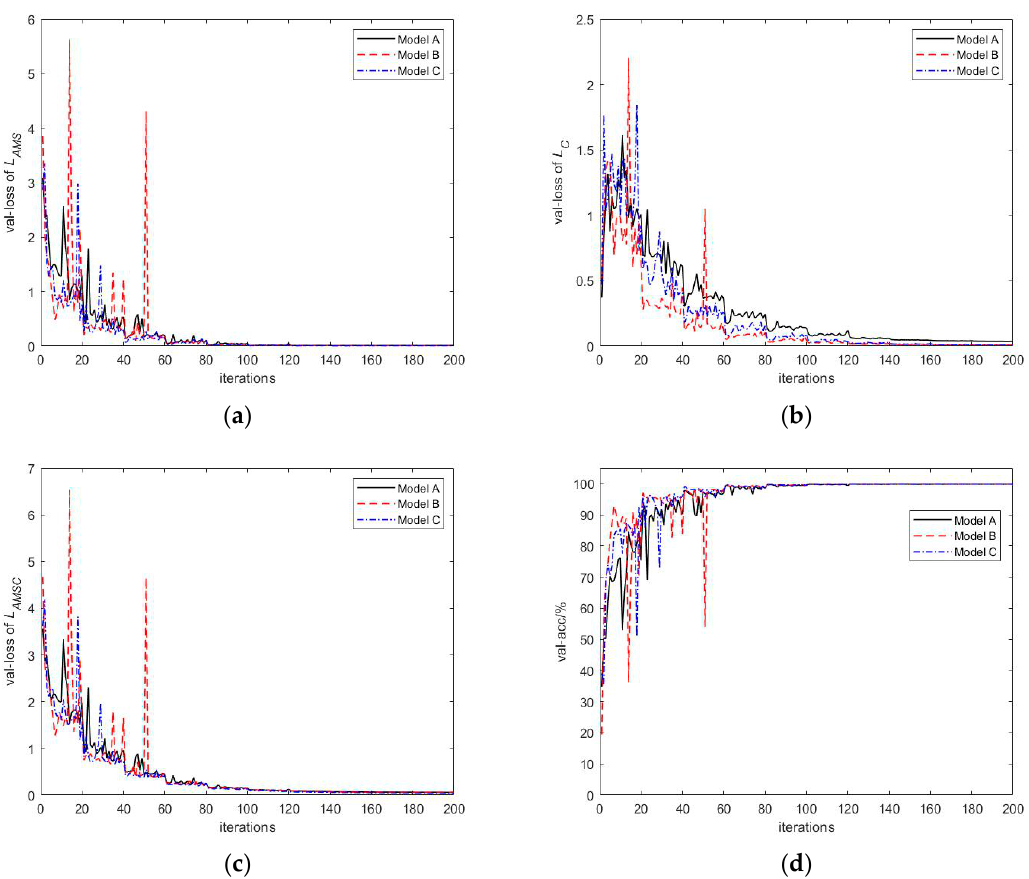
Figure 13. The recognition accuracy and loss curves in the training process at the dataset SNR of 15 dB, where val-loss and val-acc refer to the loss and recognition accuracy of the testing dataset, respectively. L AMS and L C refer to the combined parts of the joint loss function L AMSC , as shown in Equation (4). ( a ) The loss curve of L AMS ; ( b ) The loss curve of L C ; ( c ) The loss curve of L AMSC ; ( d ) The accuracy